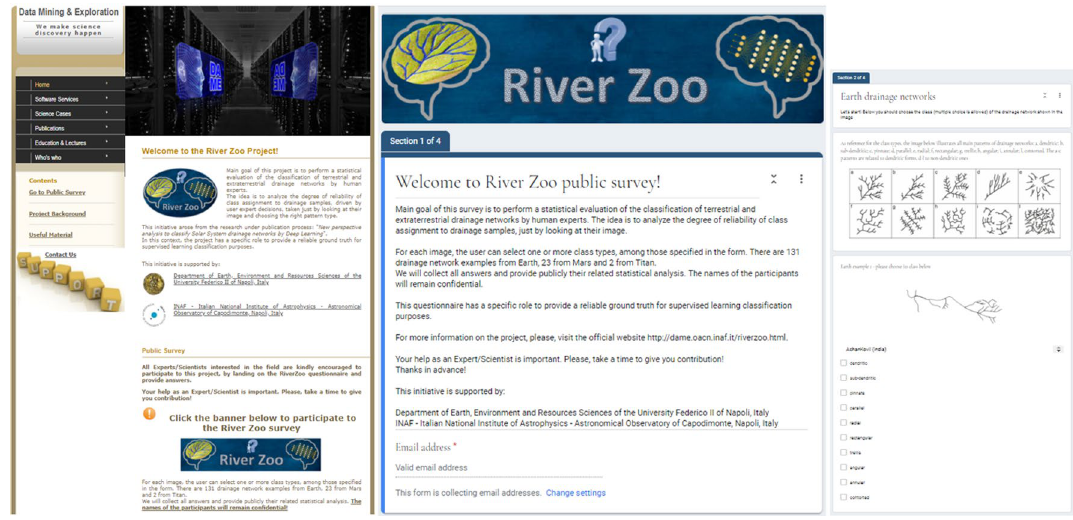
Figure 3. The River Zoo and related survey web